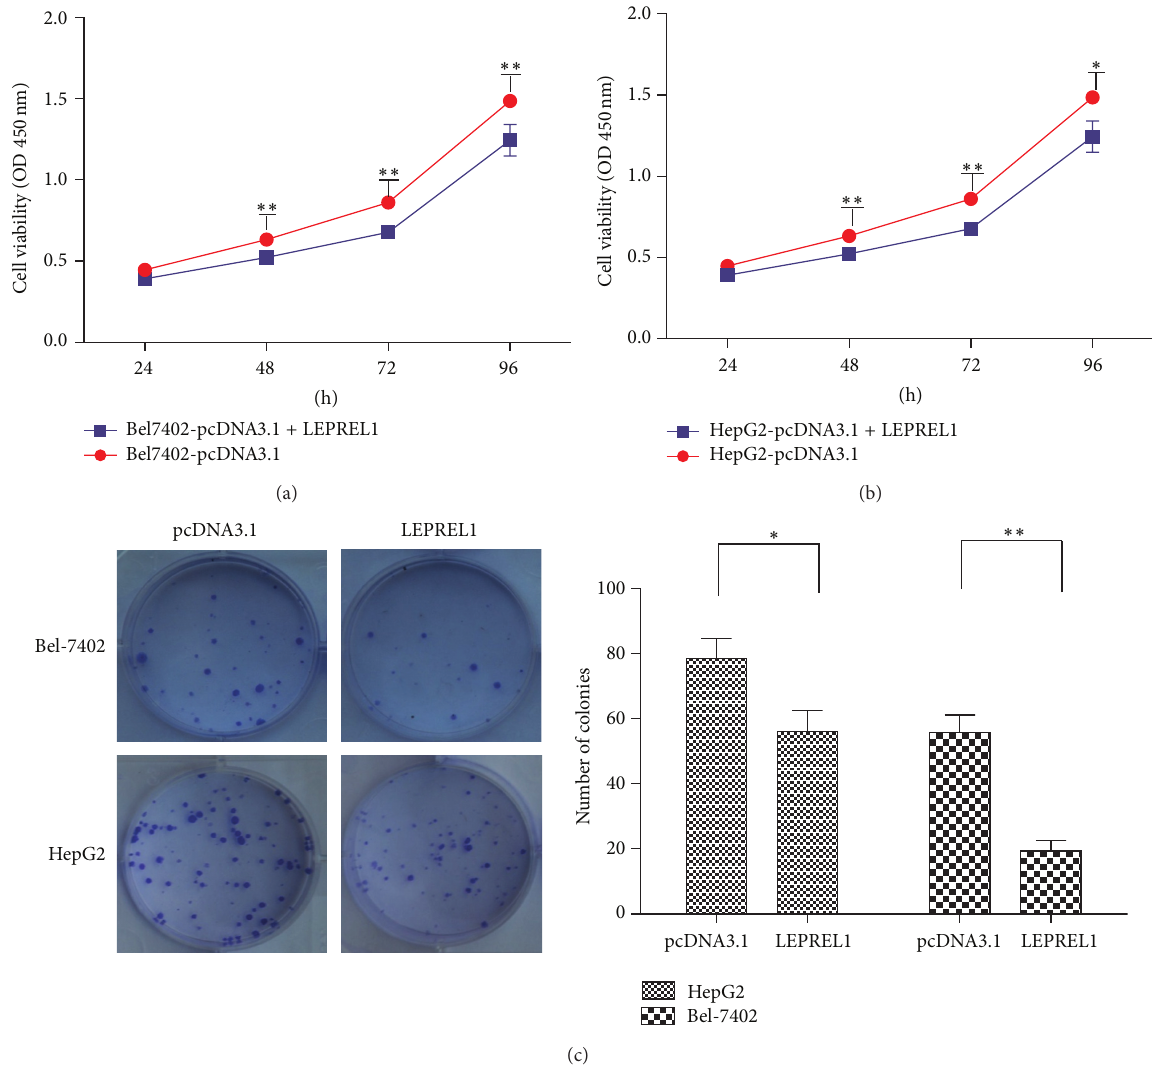
Figure 2: The effect of LEPREL1 on cell growth and colony formation. ((a) and (b)) Exogenous LEPREL1 was expressed in Bel-7402 (a), HepG2 (b) cells transfected with the pcDNA3.1 vector. Parental cells with an empty vector were used as a control. A t -test was used to show significant differences between the two groups ( 𝑃 < 0.05 ). (c) To observe the effects of LEPREL1 on colony formation, pcDNA3.1-LEPREL1 was transfected into Bel-7402 and HepG2 cells. Twenty-four hours after the transfection, the cells were plated on the dishes and were cultured in G418 for two weeks. Representative photographs of the colony formation from different stable cell lines are shown in the left panels. The colony formation rate (%) is shown in the right panels (calculated by dividing the colony numbers by 1 × 10 3 plated cells). The data (mean ± SEM) were obtained from three independent experiments ( ∗ 𝑃 < 0.05 ; ∗∗ 𝑃 < 0.01 ). The representative dishes showed the inhibitory effects of LEPREL1 on colony formation. The histogram shows that colony formation was significantly suppressed by LEPREL1 as compared with the empty vector control, where the numbers are the mean value of three independent experiments with